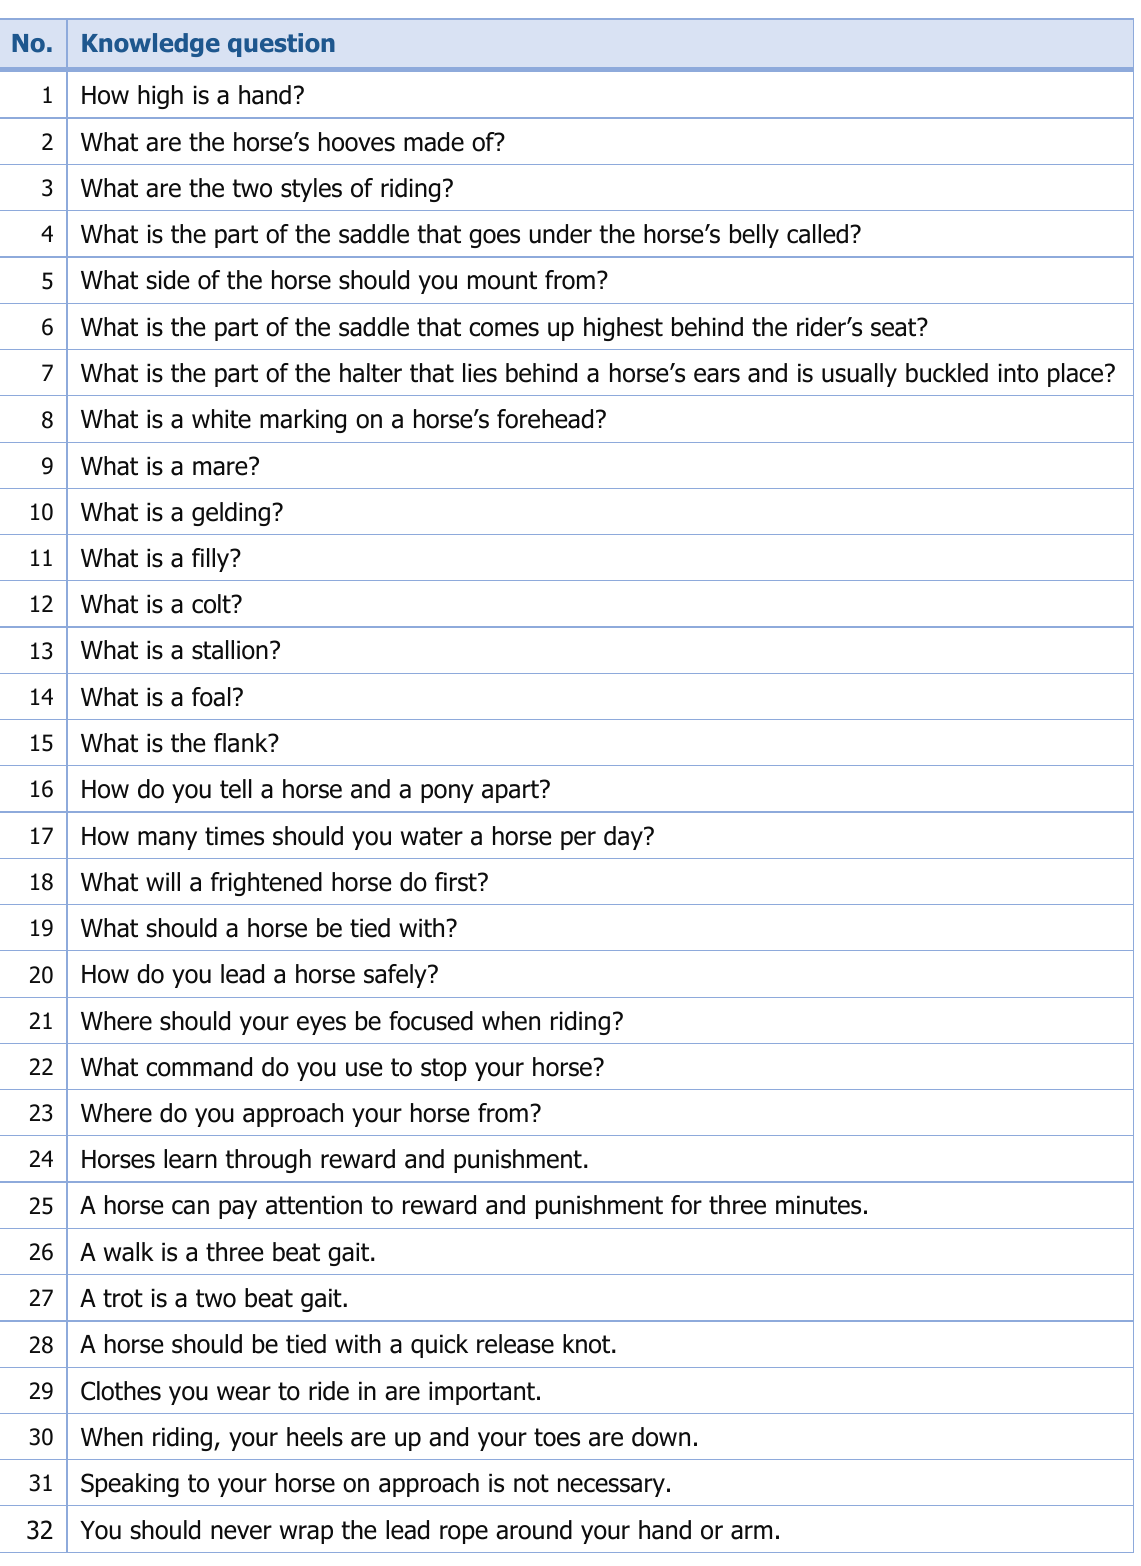
Table 2. Questions From the Equine Knowledge Pre- and Post-Program Tests